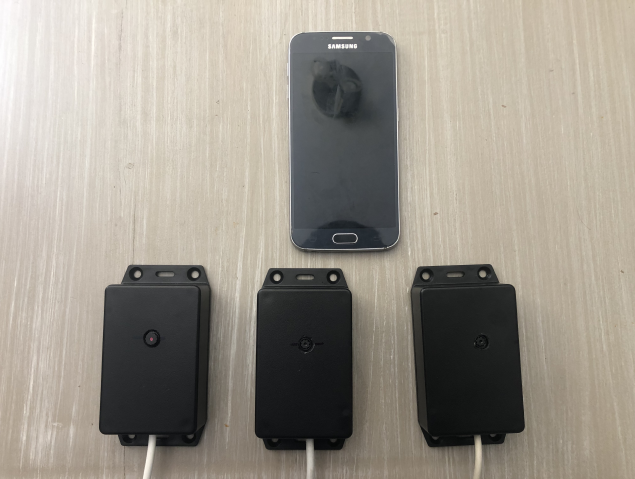
Figure 3. Android device and the three camera node